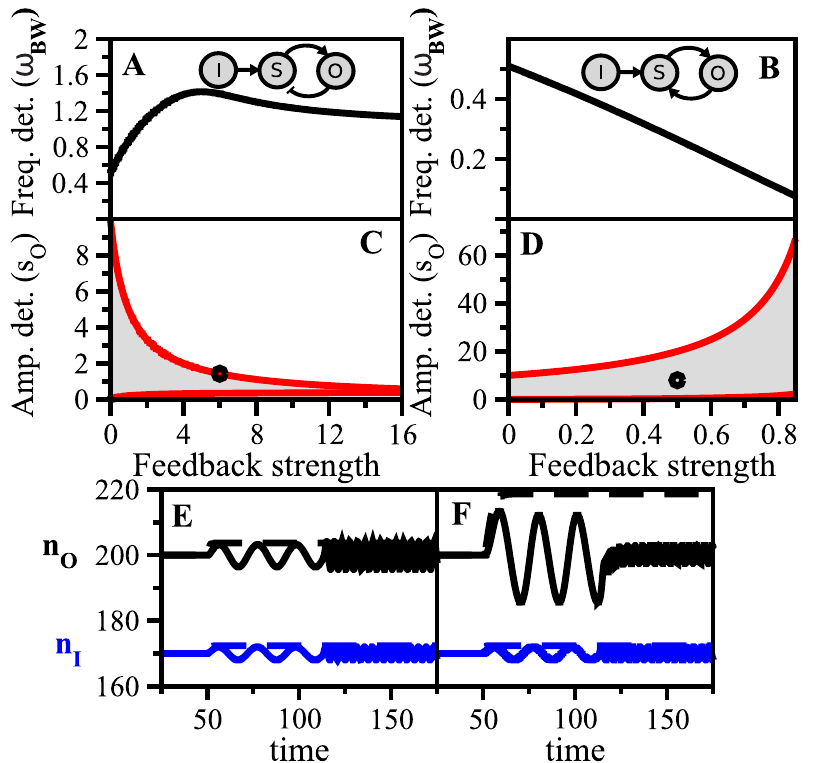
Figure 2. Amplitude/frequency detection in feedback circuits. Frequency detection (bandwidth v BW , panels A, B) and amplitude detection (output susceptibility s O , panels C, D) versus feedback strength FS for negative (left) and positive (right) feedback modules. The input/sensor susceptibility is fixed ( s SI ~ 2 ) while the other pairwise susceptibilities change in the interval ½ 0, 5 (cid:2) . Time-scales are t I ~ t S ~ t O : t ~ 1 . For each value of FS there corresponds a unique value of v BW (black solid line in Figure 2 A,B) but a range of s O ’s (shaded region between red solid lines in Figure 2C,D). (E) Blue solid line: Input signal at two different frequencies, v =0.3 and v =1.5 t { 1 , for a negative feedback circuit at FS=6 and s O * 1 : 42 (black circle in Figure 2C). Black line: Output response. Blue and black dashed lines: signal pulse of the same amplitude as the oscillatory one, and the corresponding output response, respectively. (F) Response of a positive feedback circuit with FS=0.5 and s O ~ 8 (black circle in Figure 2D) under the same signal and initial conditions.